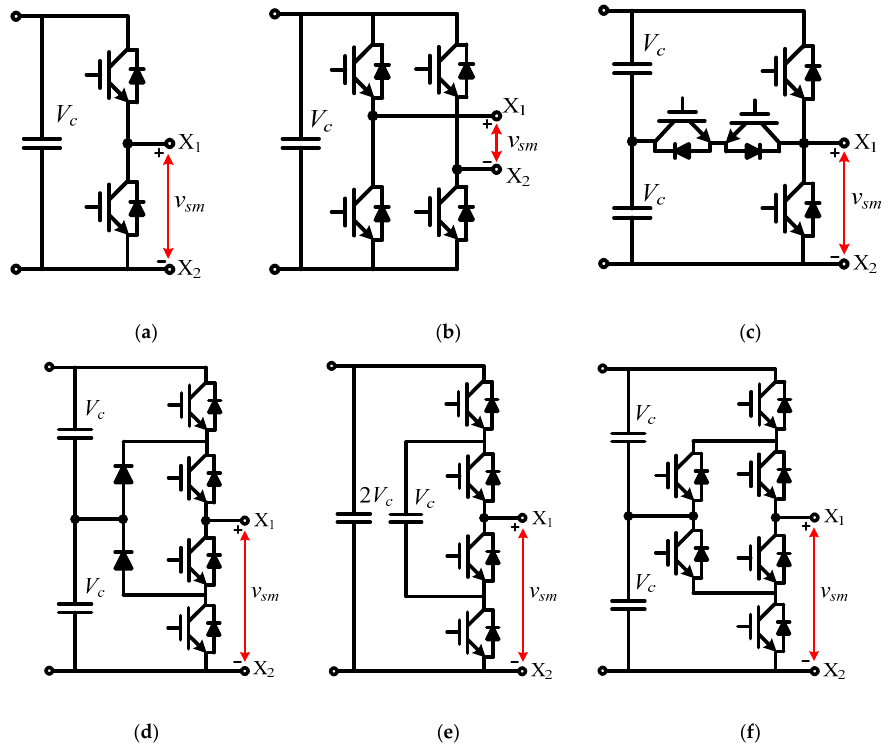
Figure 16. Structures of basic cell. ( a ) 2L HBSM, ( b ) 3L FBSM, ( c ) 3L TMSM, ( d ) 3L NPCSM, ( e ) 3L FCSM, ( f ) 3L ANPCSM.